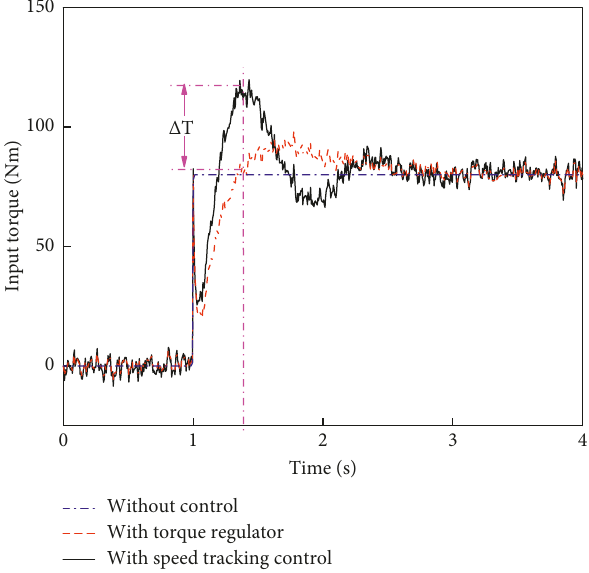
Figure 4: Engine torque with different control